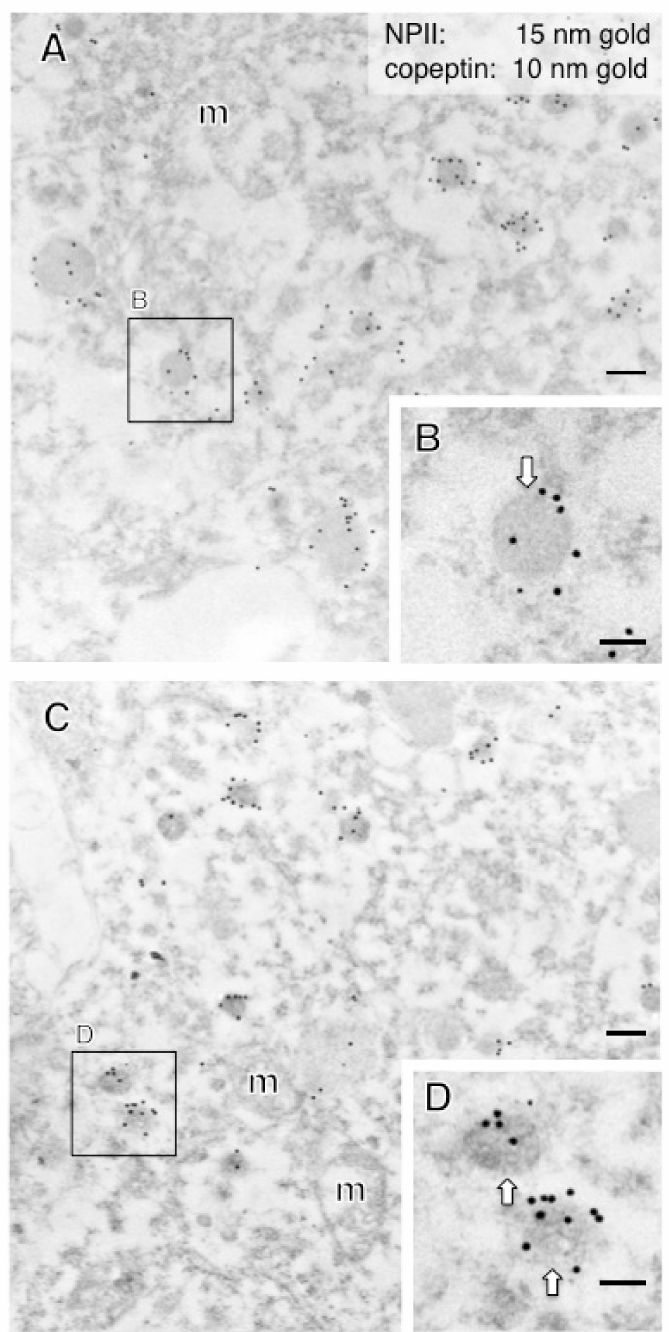
Figure 7. Double-label immunoelectron microscopy for vasopressin-associated neurophysin (NPII) and copeptin in the macaque paraventricular nucleus (PVN) of the hypothalamus. ( A ) In the cell body of a putative magnocellular vasopressin neuron, many dense-cored neurosecretory vesicles located in the cell body were doubly immunopositive for copeptin (10-nm gold particles) and NPII (15-nm gold particles). ( C ) Similar results are obtained in the cell body of a putative parvocellular vasopressin neuron. The size of dense-cored vesicles in ( A , B ) was larger than that of vesicles in ( C , D ). The outlined areas are enlarged. Scale bars, 200 nm, and 100 nm in enlarged images. Arrows indicate dense-cored neurosecretory vesicles. m,